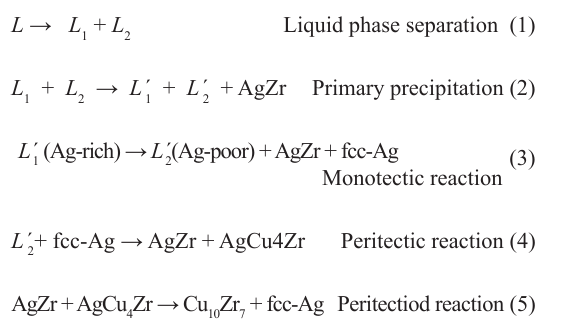
Cu Zr ribbon 60 20 20